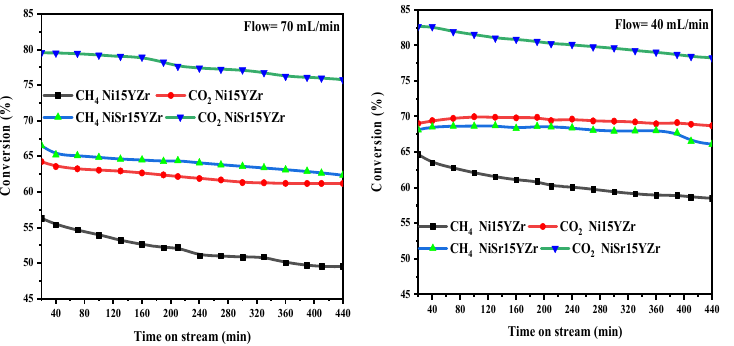
Figure 13. Conversion versus time on stream for 5Ni15YZr and 5NiSr15YZr at different feed flow rates.